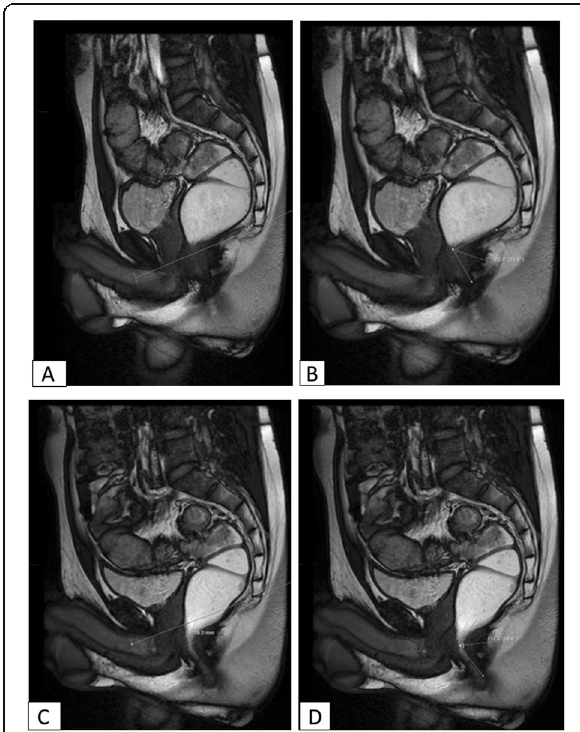
Fig. 1 Mid-sagittal SSFP obtained ( a , b ) at rest and ( c , d ) during defecation showing at rest rectum and bladder above the PCL and ano-rectal angle measuring 85°, c , d during defecation showing descent of ano-rectal junction 1.9 cm below the PCL [normal up to 2 cm] and increase in ano-rectal angle above 20° to be